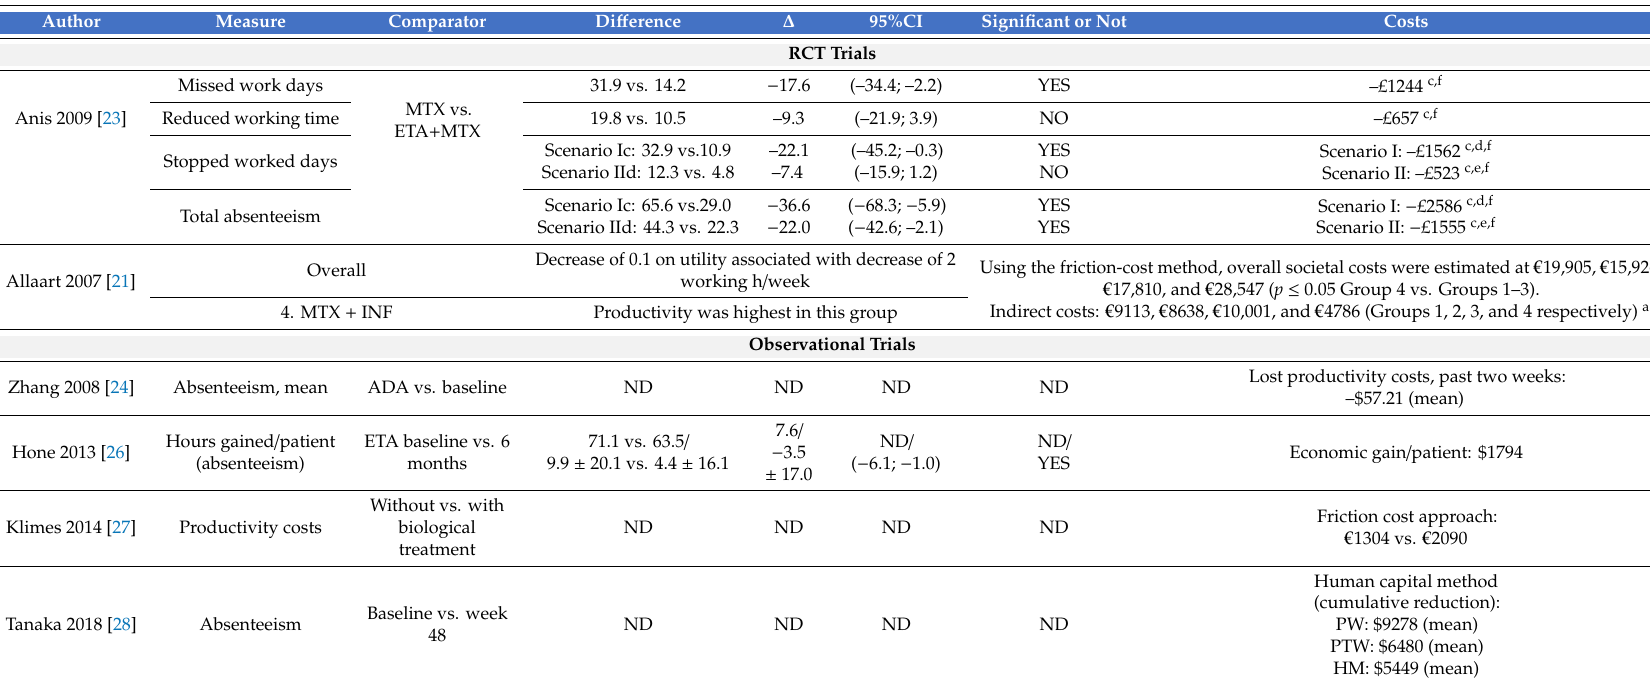
Table 2. E ff ect of biological treatment on absenteeism